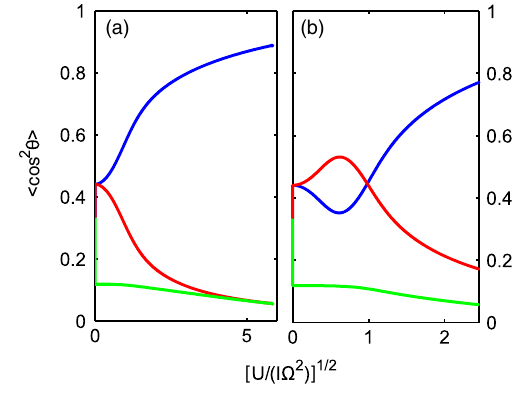
FIG. 2. h cos 2 (cid:2) x i (blue), h cos 2 (cid:2) y i (red), and h cos 2 (cid:2) z i (green) (see text) as a function of and (b) (cid:1) ¼ 3 : 5 B